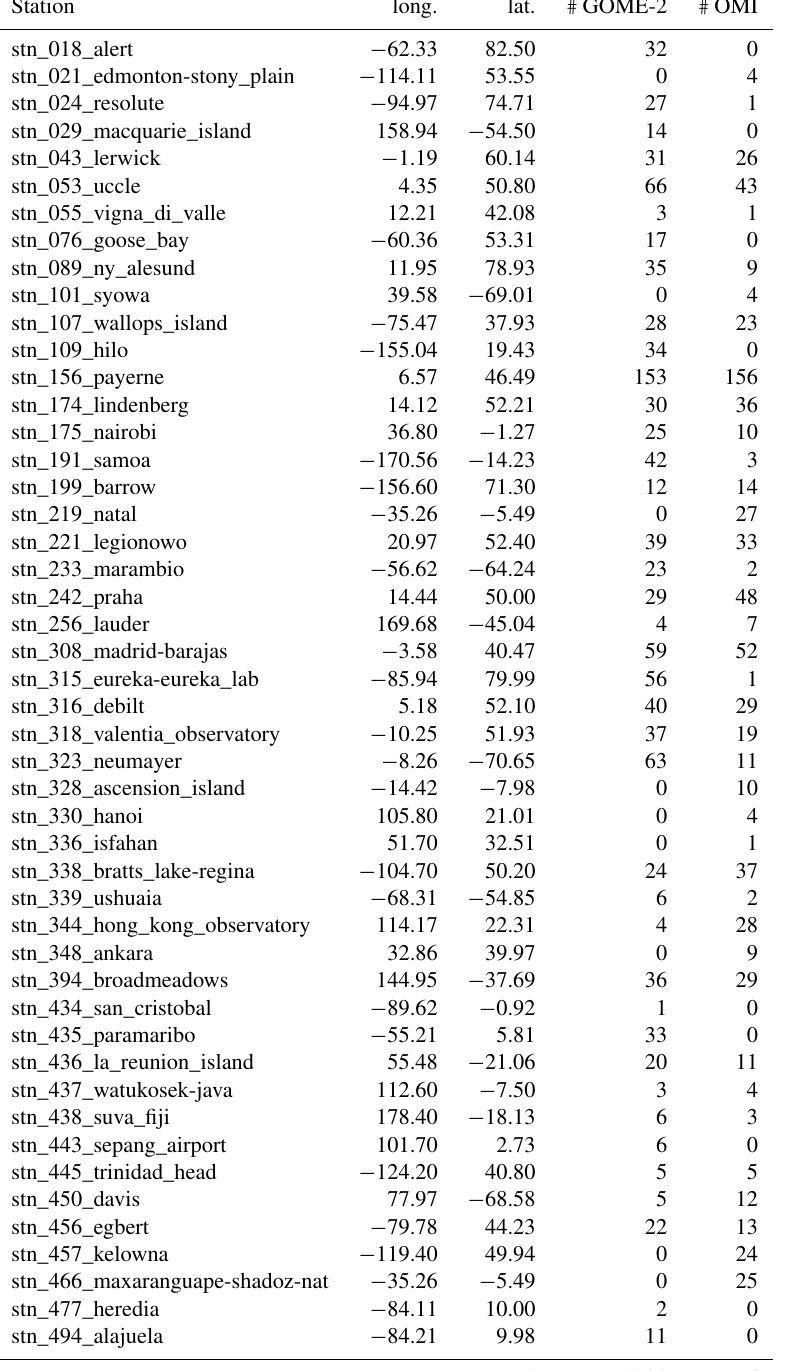
Table 1. Stations used for the validation and bias correction of GOME-2 and OMI.